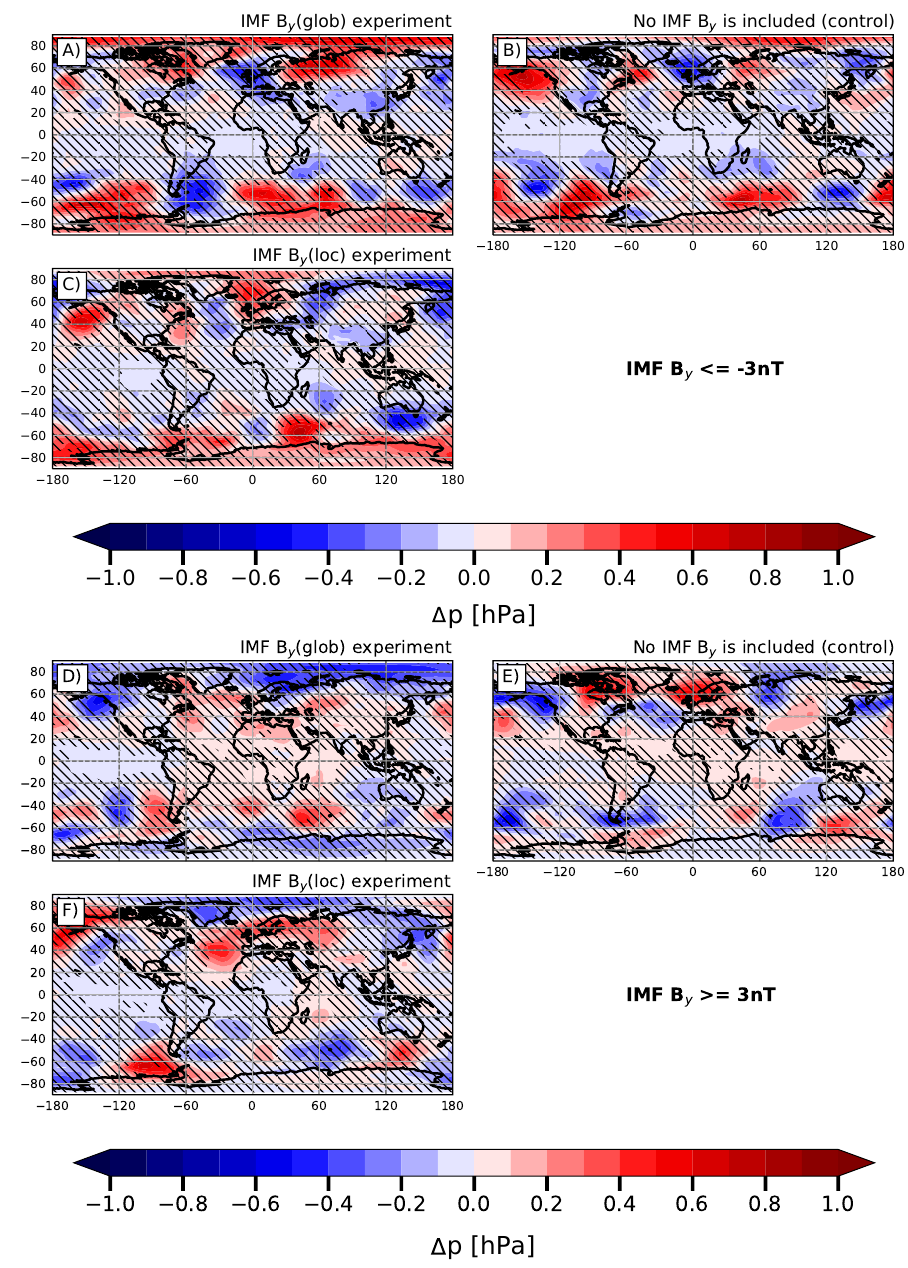
p [hPa] Figure 5. Ensemble-mean geographical distribution of ∆ p averaged for the interval 1999-2002. Panels A,B, and C: ∆ p averaged over days with daily-mean IMF B y <= -3nT from B y (glob) ( A ), control ( B ), and B y (loc) ( C ) experiments; Panels D,E, and F: ∆ p averaged over days with daily-mean IMF B y >= 3nT from B y (glob) ( D ), control ( E ), and B y (loc) ( F ) experiments. Hatches represent the probability of ∆ p less than 95%.